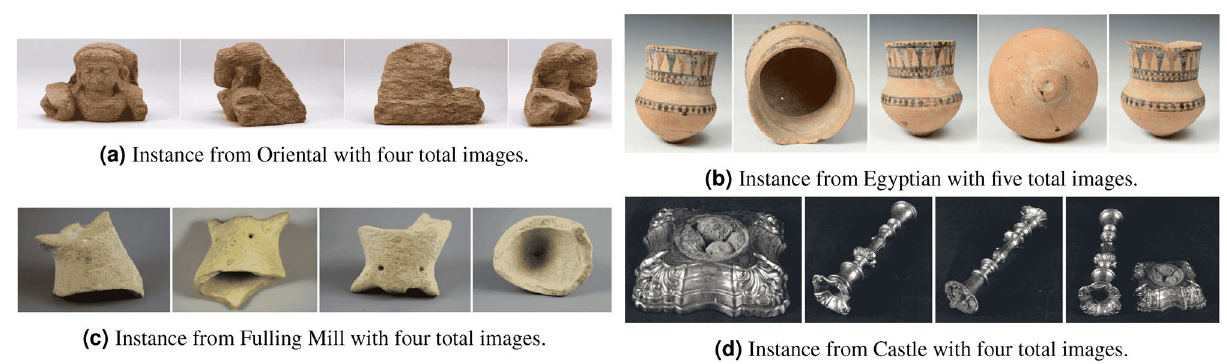
Figure 2. Images from instances of each of the four subcategories: ‘Oriental’, ‘Egyptian’, ‘Fulling Mill’, and ‘Castle’.